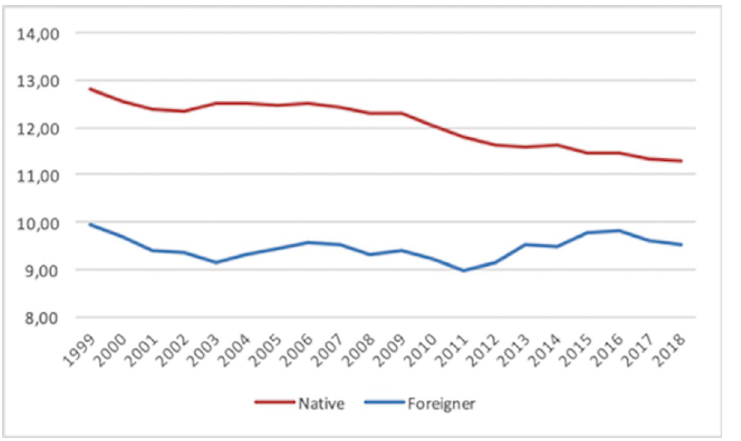
Fig 1. Total self-employment rate 1999–2018. Country